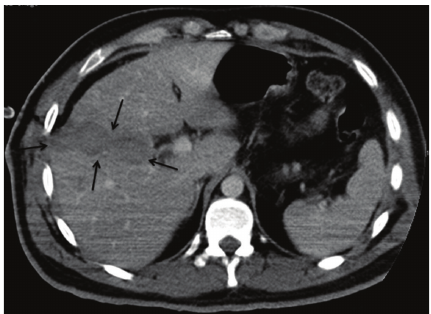
Figure 1: CT imagination of liver rupture.